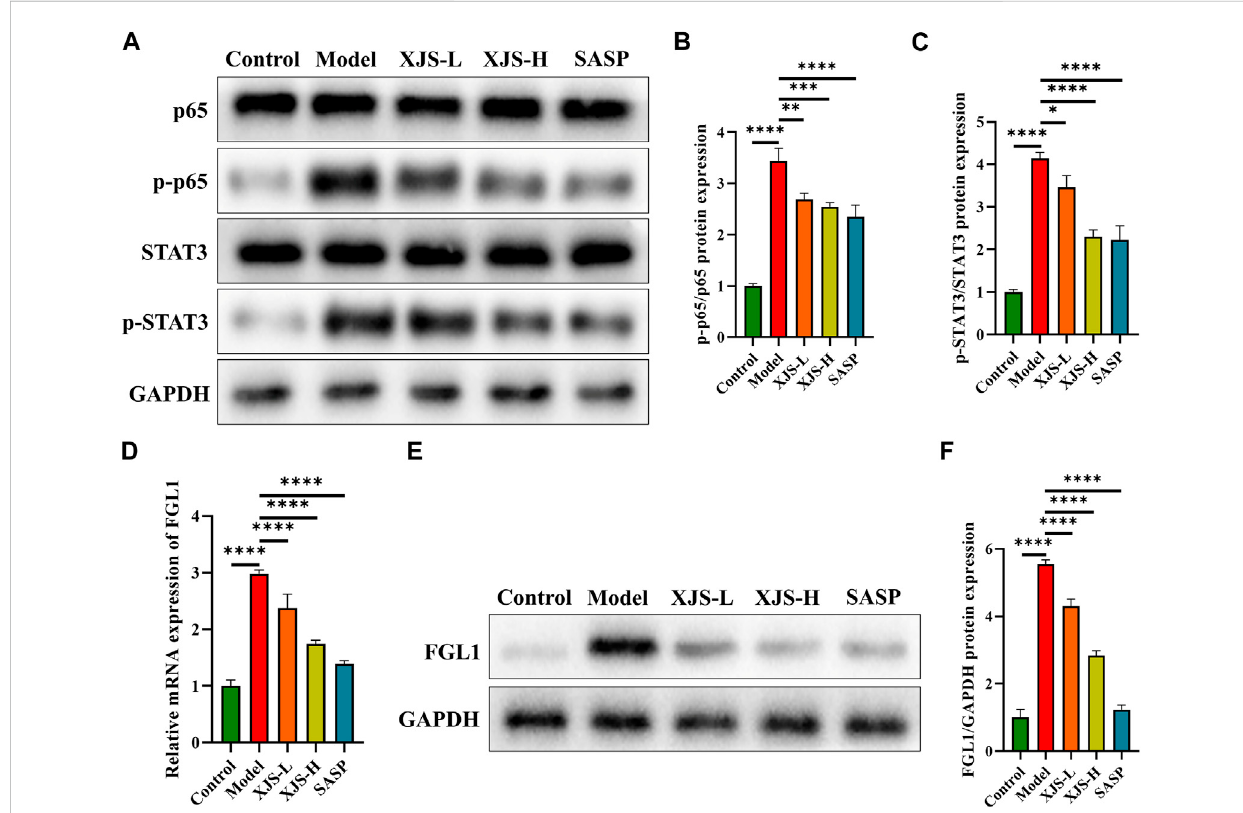
FIGURE 7 XJSinhibitedFGL1/NF- κ B/STAT3positivefeedbackloop. (A – C) Theproteinexpressionsofp65andSTAT3( n =3). (D) ThemRNAexpressionsofFGL1 ( n = 6). ( E, F) The protein expressions of FGL1 ( n = 3). * p < 0.05, ** p < 0.01, *** p < 0.001, **** p <